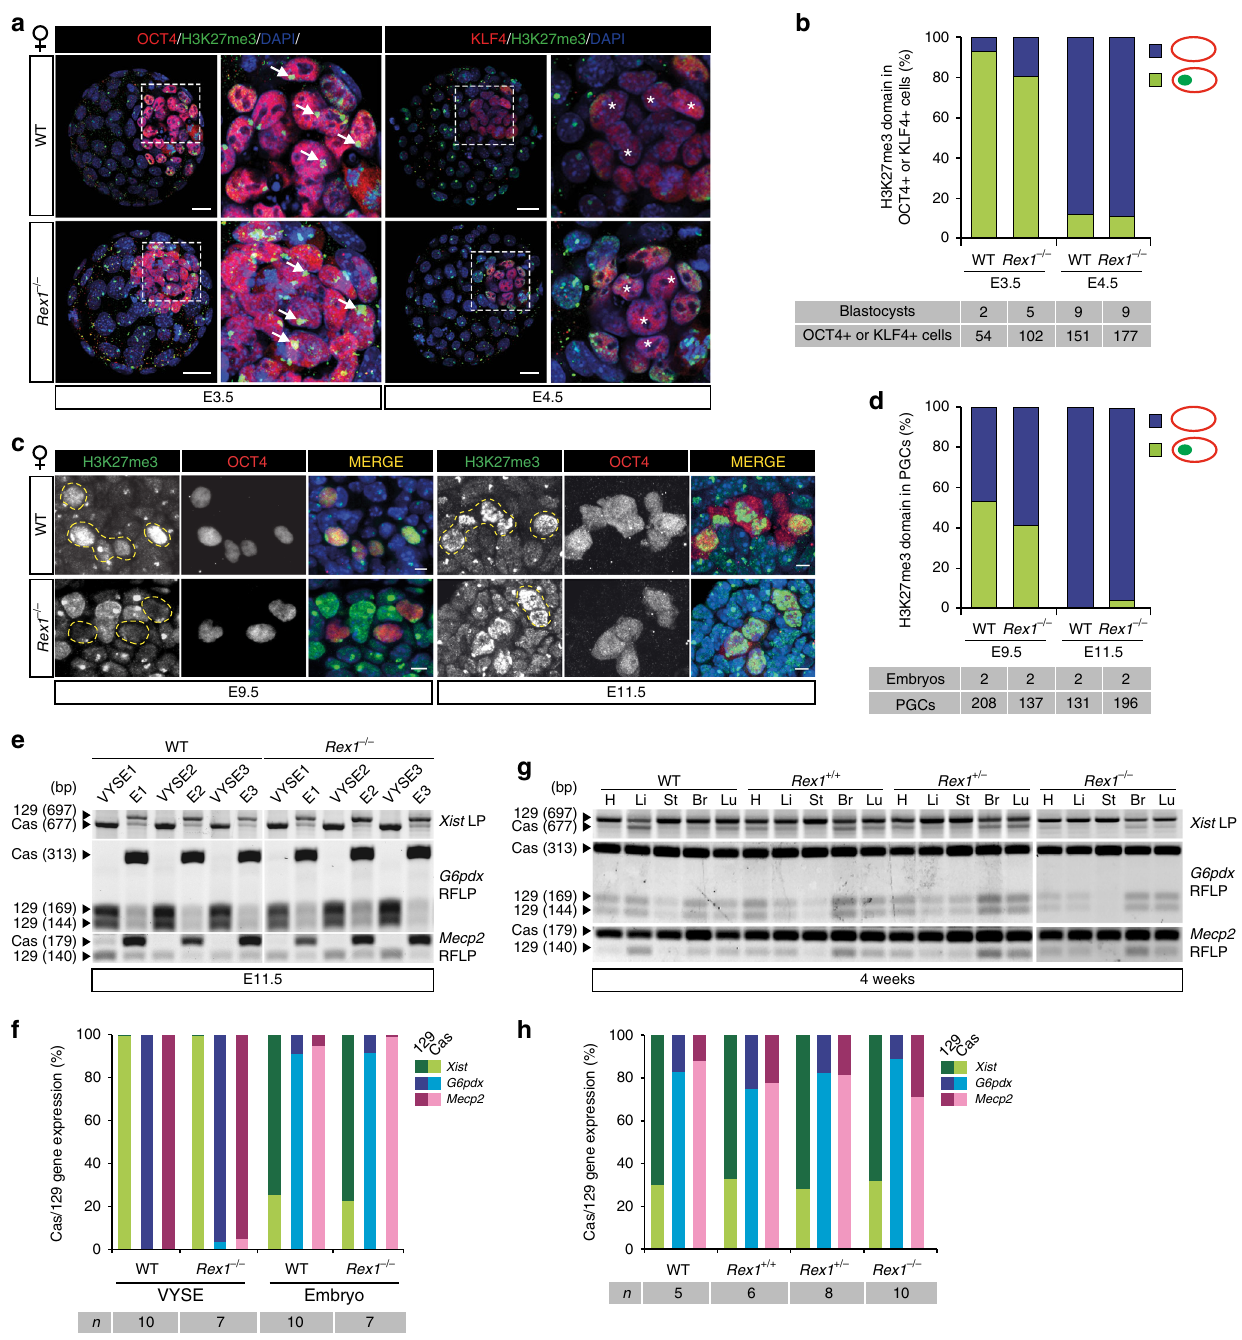
Fig. 3 XCR and imprinted and random XCI in female Rex1 − / − mice are not compromised. a Representative Z -stack projections of WT and Rex1 − / − E3.5 and E4.5 female blastocysts immunostained for H3K27me3 (Xi marker, green), the lineage markers OCT4 (E3.5 ICM, red, left panels) and KLF4 (E4.5 epiblast, red, right panels) and DNA (DAPI, blue). Whole embryo and ICM/epiblast higher magni fi cation for each embryo are shown (white boxes). Arrowheads mark the Xi in OCT4 + cells. KLF4 + cells display XCR (stars). Scale bars: 20 μ m. b Quanti fi cation of H3K27me3 domains (green) in E3.5 and E4.5 ICMs of WT and Rex1 − / − embryos in a . c Representative paraf fi n sections of female WT and Rex1 − / − E9.5 embryo hindguts and E11.5 embryo trunks immunostained for OCT4 (PGC marker, red) and H3K27me3 (Xi marker, green). H3K27me3 domains are present in somatic cells and in some E9.5 PGCs, while they are lost in E11.5 PGCs (XCR). Representative PGCs are marked with yellow dashed lines. Scale bars: 5 μ m. d Quanti fi cation of cells with an H3K27me3 domain in female WT and Rex1 − / − PGCs at E9.5 and E11.5. Number of embryos and PGCs analysed are indicated. e Xist , G6pdx and Mecp2 allele-speci fi c RNA expression analysis in E11.5 WT and Rex1 − / − female embryos (E) and corresponding VYSE. LP, length polymorphism. f Quanti fi cation of the average allelic Xist (green), G6pdx (blue) and Mecp2 (pink) expression in WT and Rex1 − / − embryos and VYSE in e . Light/dark colours indicate cas or 129 allelic origin, respectively. The number of mice analysed is indicated. g Representative Xist , G6pdx and Mecp2 allele-speci fi c RNA expression analysis in heart (H), liver (Li), stomach (St), brain (Br) and lung (Lu) of WT, Rex1 + / + (from a heterozygous cross), Rex1 + / − and Rex1 − / − 4-week-old mice. h Quanti fi cation of the average allelic Xist (green), G6pdx (blue) and Mecp2 (pink) expression in several WT, Rex1 + / + (from a heterozygous cross), Rex1 + / − and Rex1 − / − 4-week- old mice in g and additional mice. Light/dark colours indicate cas or 129 allelic origin, respectively. The number of mice analysed is